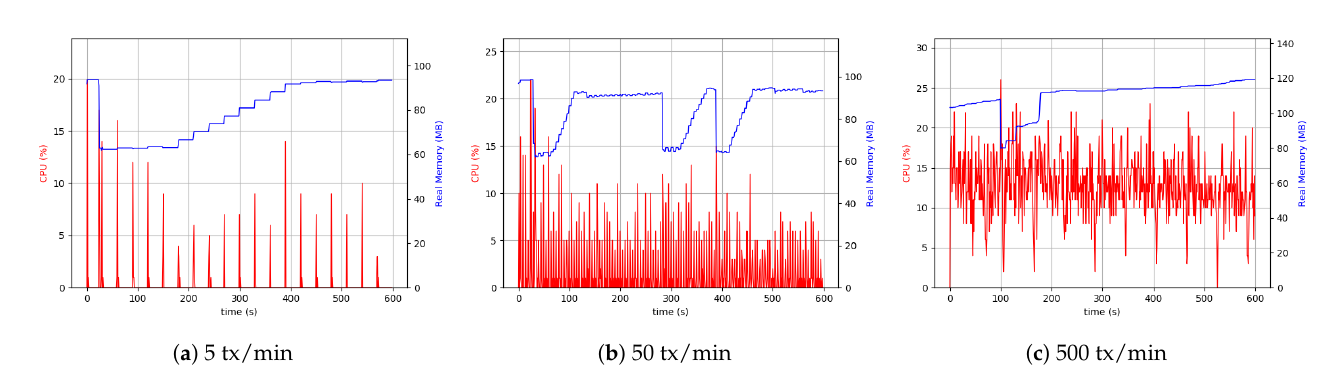
Figure 15. CPU and memory for varying data sizes for client process in RPi